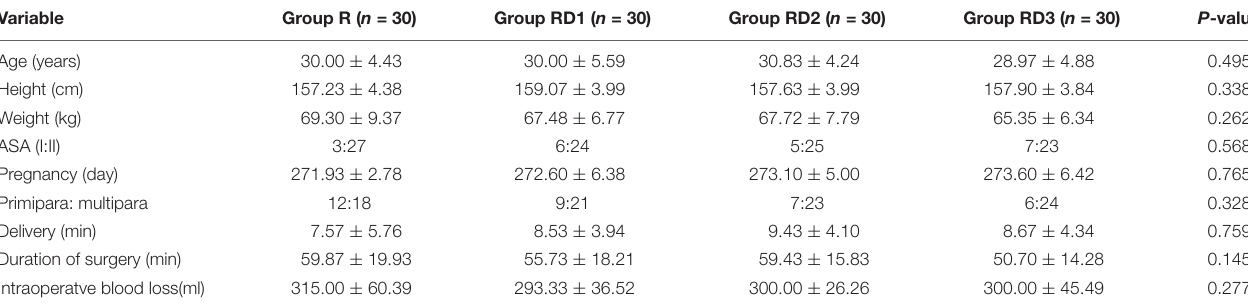
TABLE 2 | Patients demographics and surgical